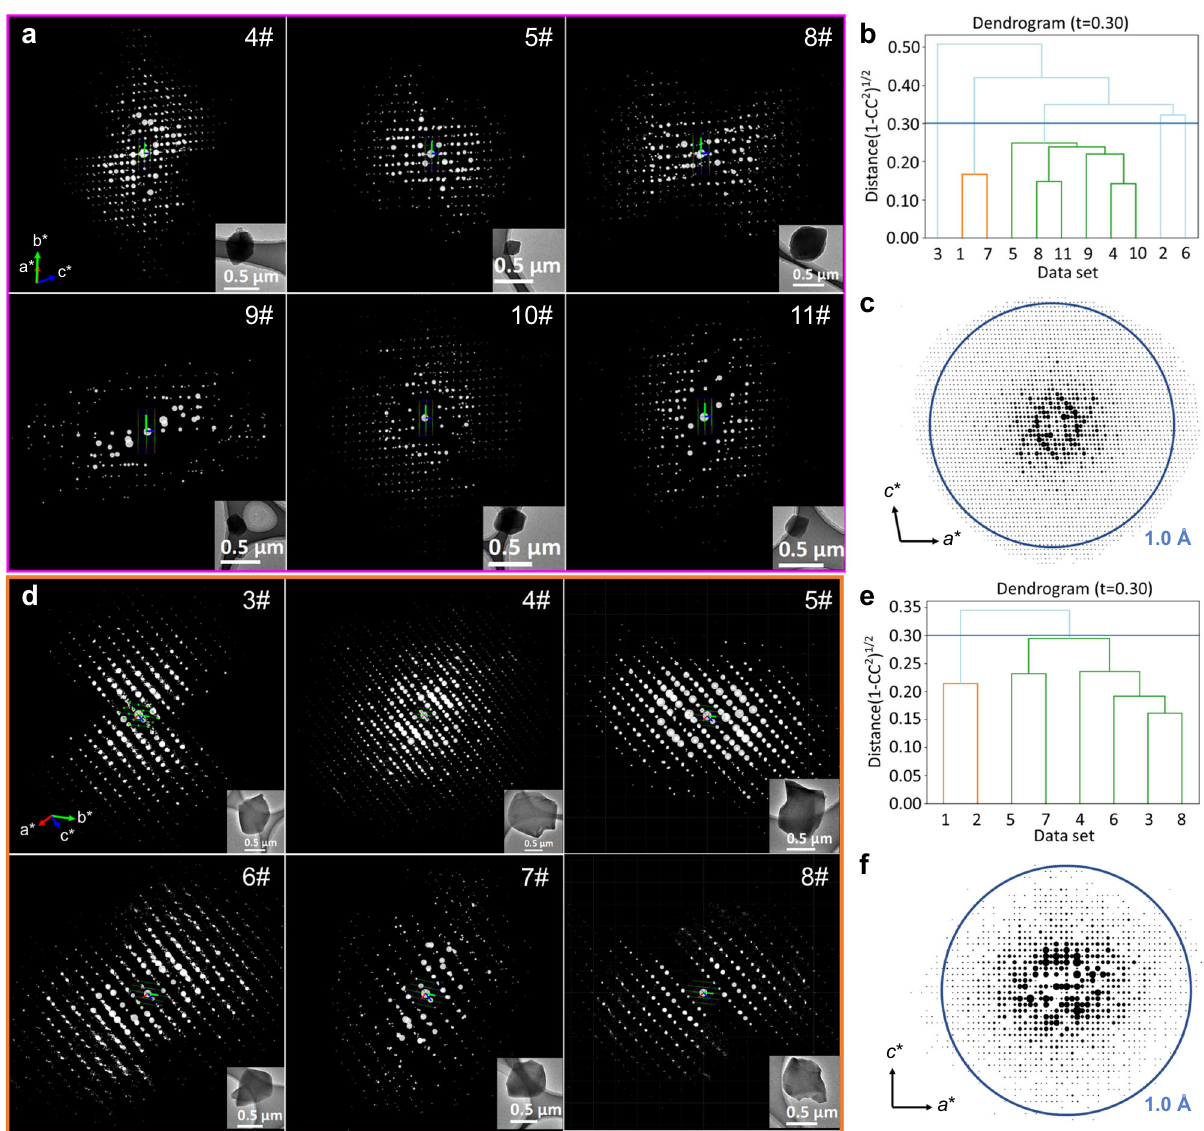
Fig. 3 3D ED and HCA of 3D-TPB-COF-OMe and 3D-TPB-COF-Me. The overview of automatically selected six 3D ED datasets of 3D-TPB-COF-OMe ( a ) and 3D-TPB-COF-Me ( d ) for merging and scaling. The dendrogram shows the results of the hierarchical cluster analysis (HCA) of extracted intensities using the correlation coef fi cients of the common re fl ection intensities ( CC I ) between pairs of datasets. The cut distance is represented by the blue line at 0.30 (corresponding to CC I = 0.95) for 3D-TPB-COF-OMe ( b ) and 3D-TPB-COF-Me ( e ). In total, the largest clusters were identi fi ed with six cRED datasets for 3D-TPB-COF-OMe ( b , in green) and 3D-TPB-COF-Me ( e , in green), which were selected for the structure determination and re fi nement. The overview of merged 3D reciprocal lattices of 3D-TPB-COF-OMe ( c ) and 3D-TPB-COF-Me ( f